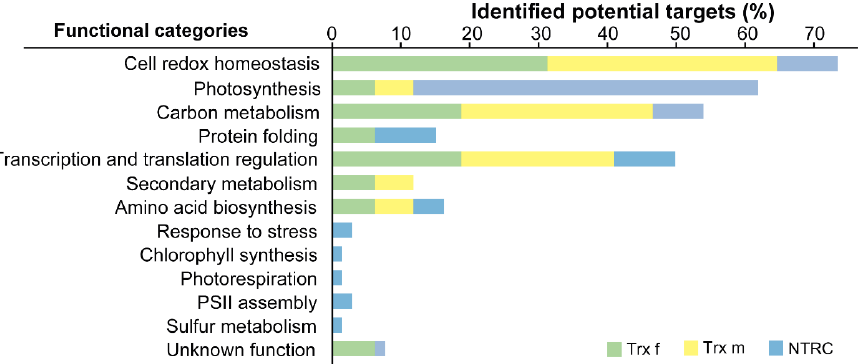
Figure 3. Functional classification of proteins identified as putative Trx f, Trx m or NTRC partners in chloroplasts. The plot represents the percentage of total targets for each Trx in each functional category.